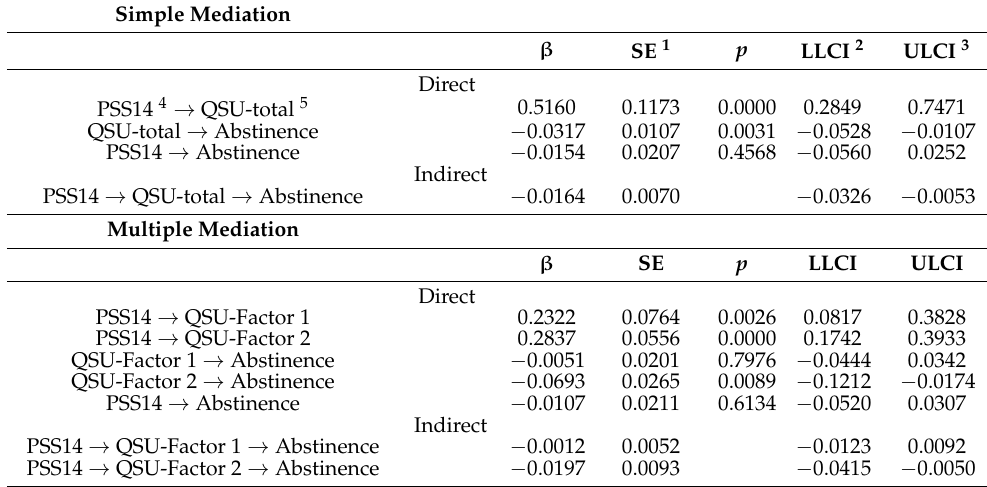
Table 3. Results of simple and multiple mediation analyses controlling for